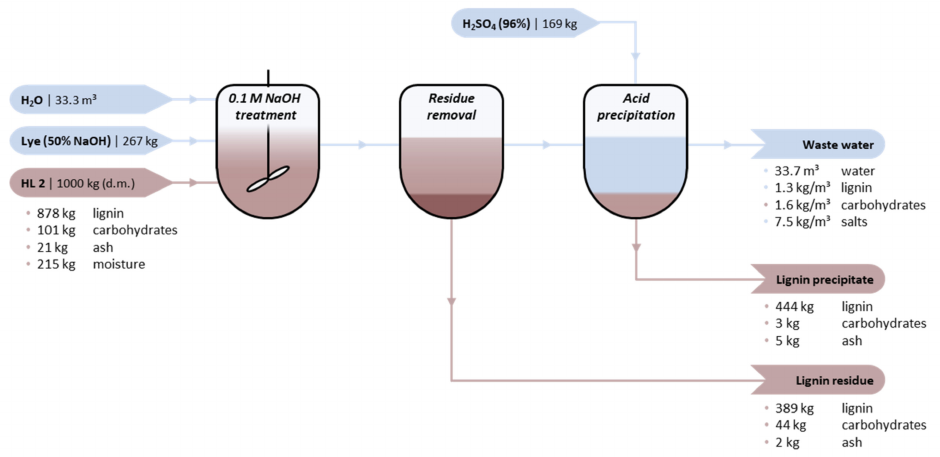
Figure 8. Simplified mass flow scheme for the batch alkaline hydrolysis-acid precipitation of 1000 kg HL2. Washing steps are not included for simplicity. Process parameters: 0.1 M NaOH, W lign = 0.03, and T = 25 ◦